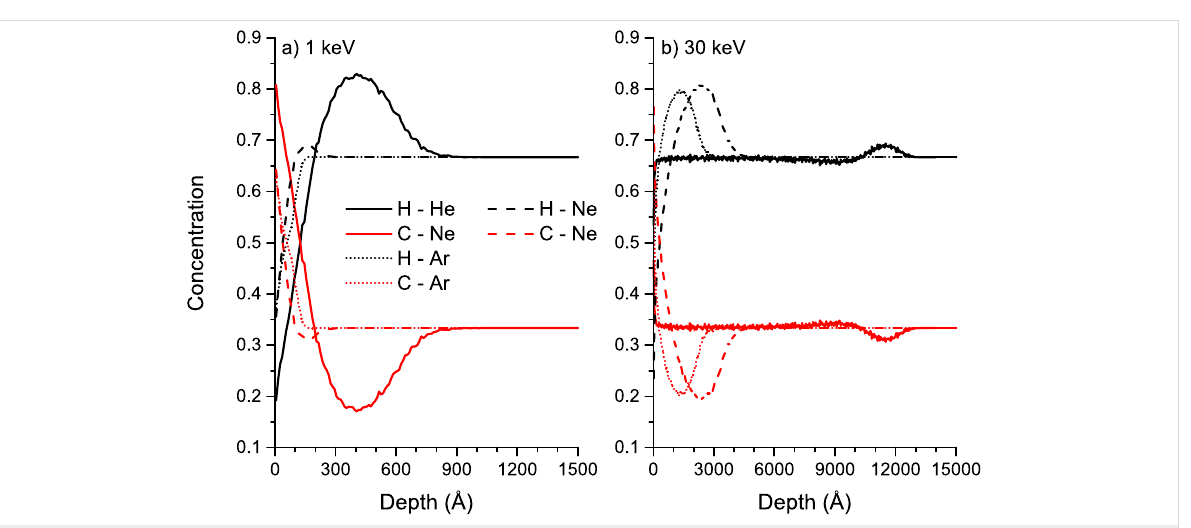
Figure 13: Concentration profiles of H and C at a fluence of 10 18 ions/cm 2 for He, Ne and Ar bombardment of PE: a) for 1 keV, and b) for 30 keV impact energy. The results have been obtained by